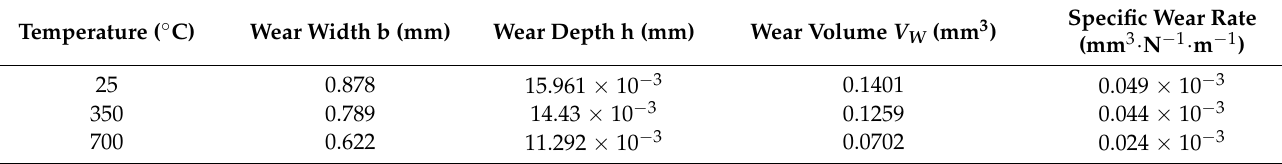
Table 7. The wear width, depth, volume, and specific wear rate of alloying coating under different temperature. Temperature ( ◦ C)